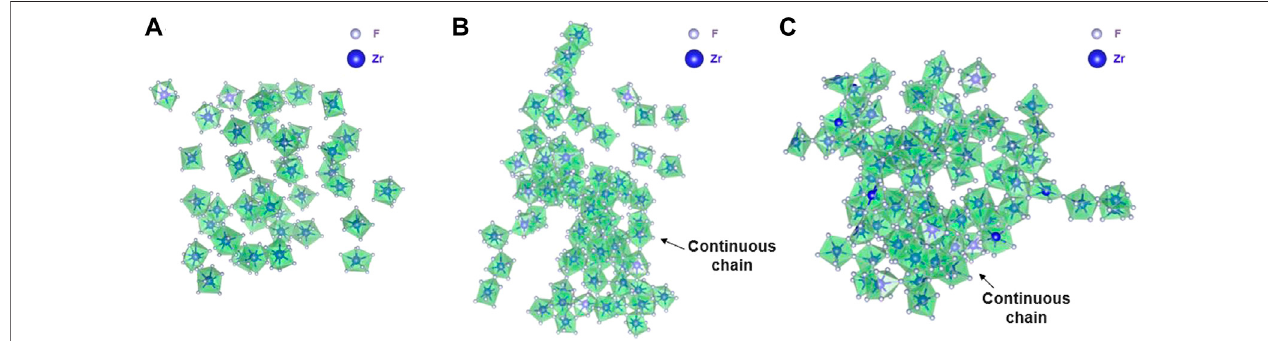
FIGURE 8 | Snapshots from RIM-IPMD calculations showing (A) no chain formation in Composition A at 750 ° C, (B) a long continuous fl uorozirconate chain ([ZrF x4 − x ] n )involving91%ofZr(65/72)inCompositionBat727 ° C,and (C) alongcontinuous fl uorozirconatechain([ZrF x4 − x ] n )involving~99%ofZr(89/90)inComposition C at 700 ° C. Chain is created by edge and corner-sharing among 7-, 8-, and 9-fold coordinated fl uorine zirconium complexes. Na, Li, and “ free ” fl uorine atoms are removed during visualization.